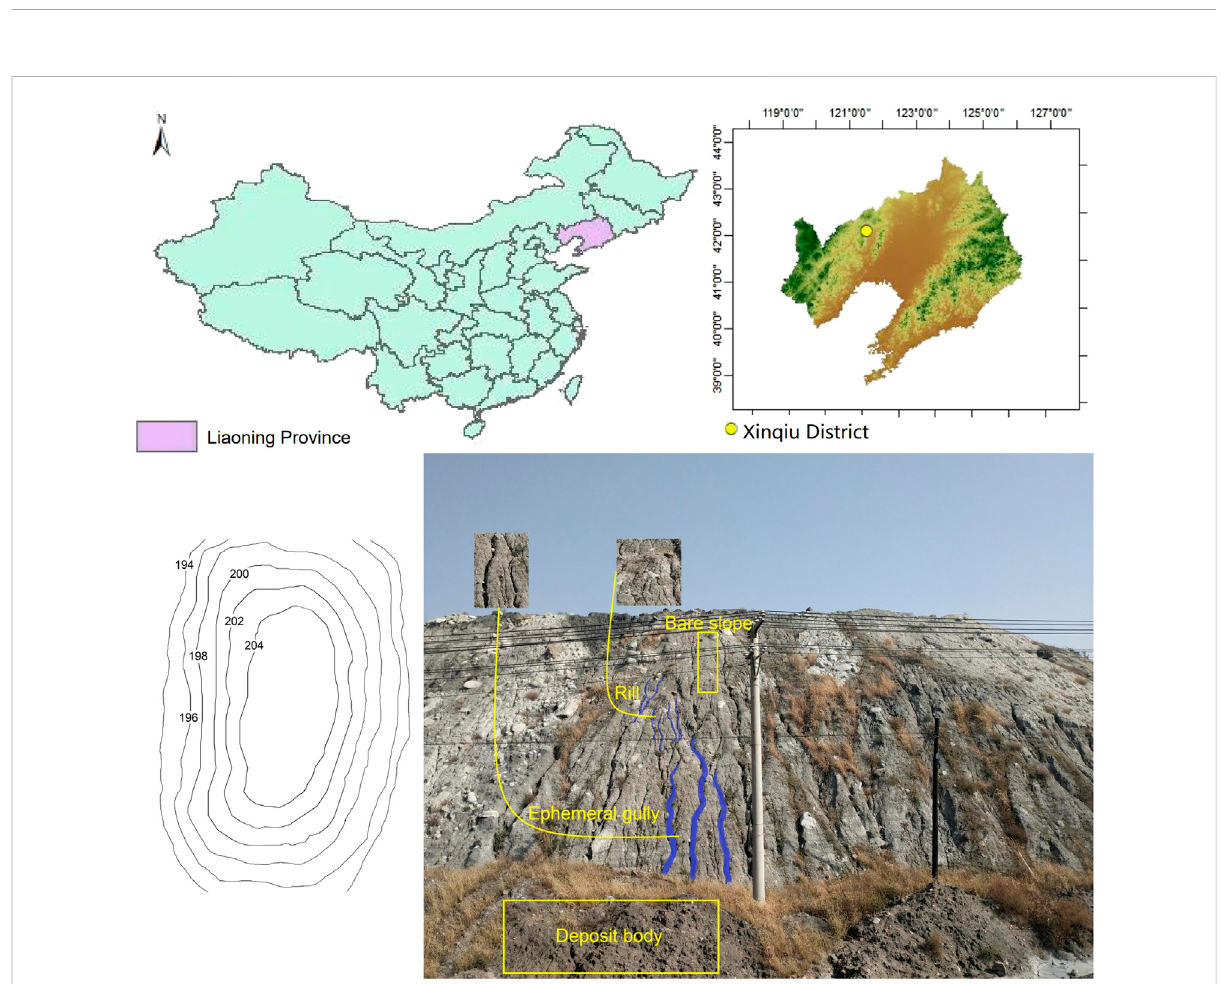
FIGURE 1 Location of the study area, the erosion micro-topographies on the waste dump, and its contour